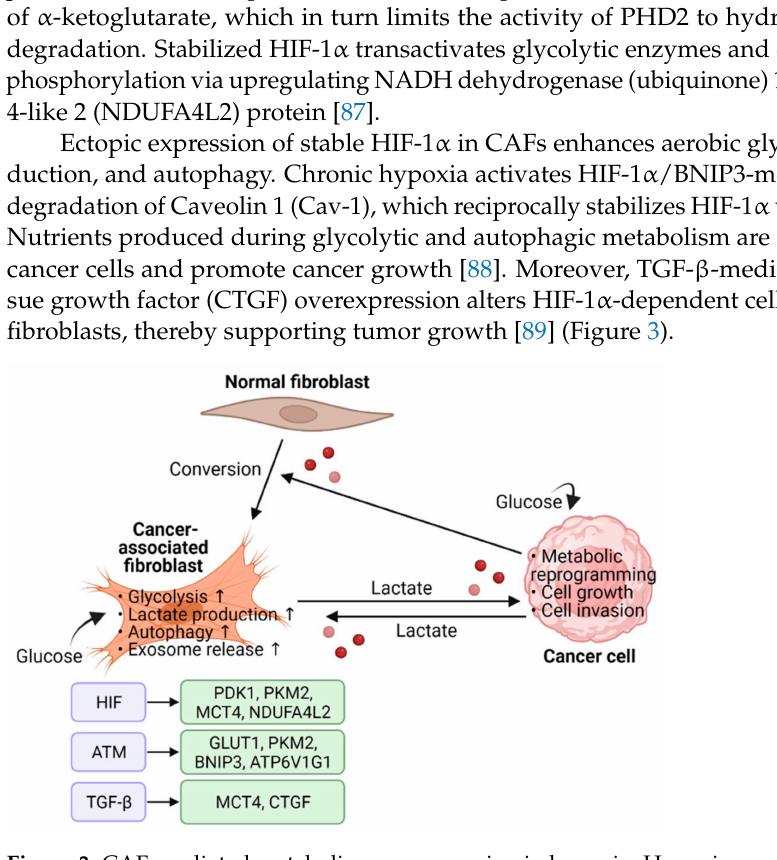
Figure 3. CAF-mediated metabolic reprogramming in hypoxia. Hypoxia regulates cell